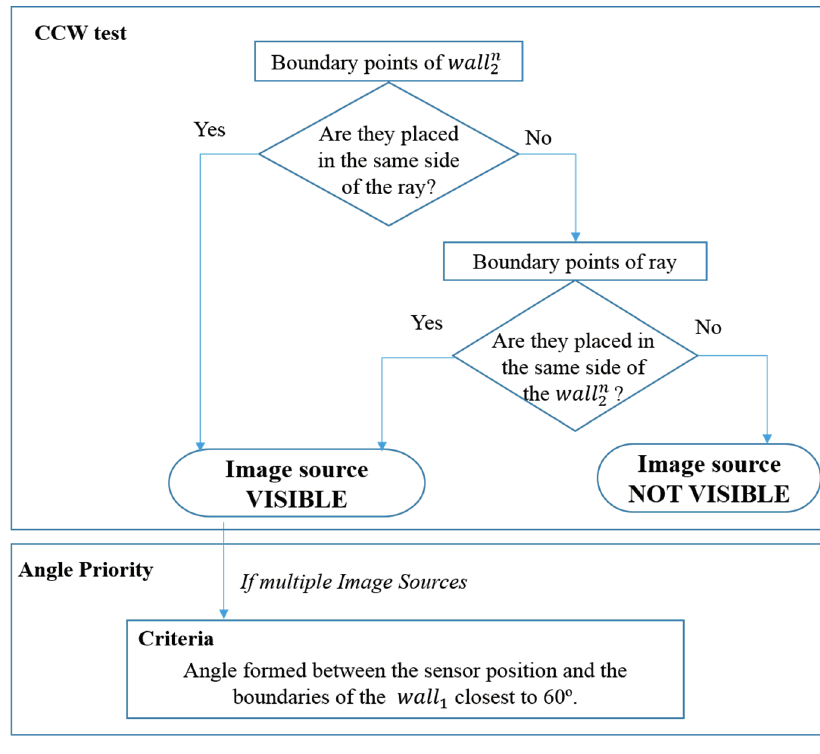
Figure 7. Schema of the visibility analysis.